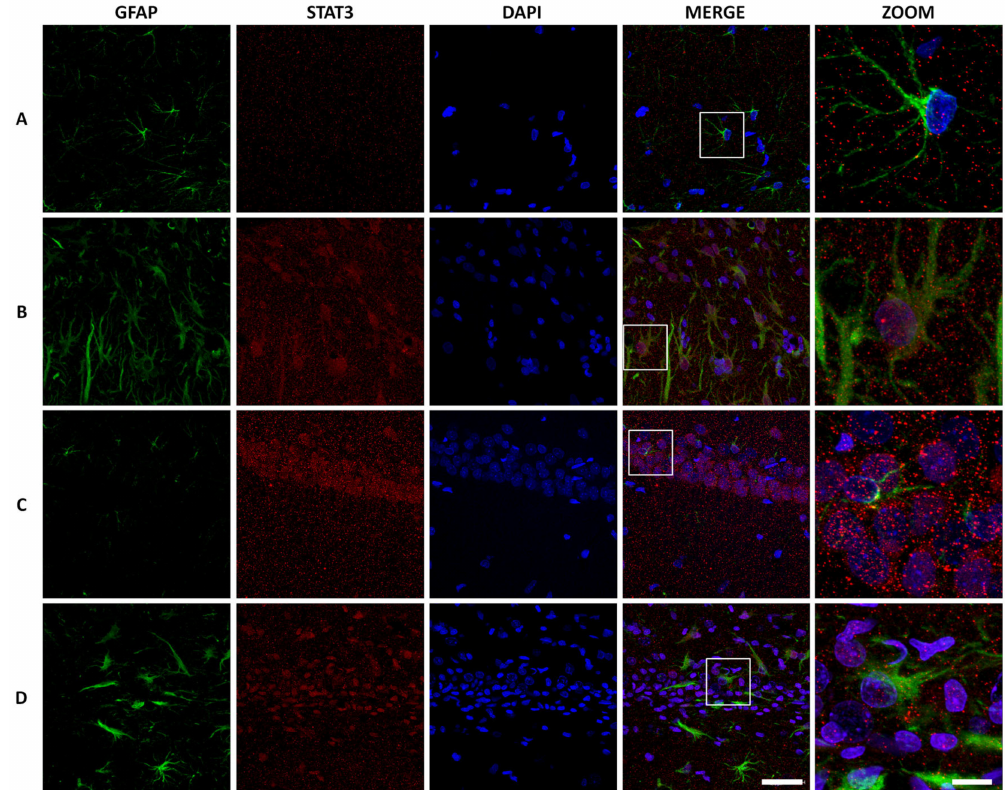
Figure 10. STAT3 expression in astrocytes. Immunofluorescence representative 63 × images with digital zoom (scale bar 63 × images = 40 µ m, zoom = 10 µ m) show an increased nuclear STAT3 expression (Alexa 555) in astrocytes mediated by A β O (Alexa 488), 72 h and 7 days after microinjection. The 7 day-saline solution control showed a cytoplasm STAT3 expression as previously observed in